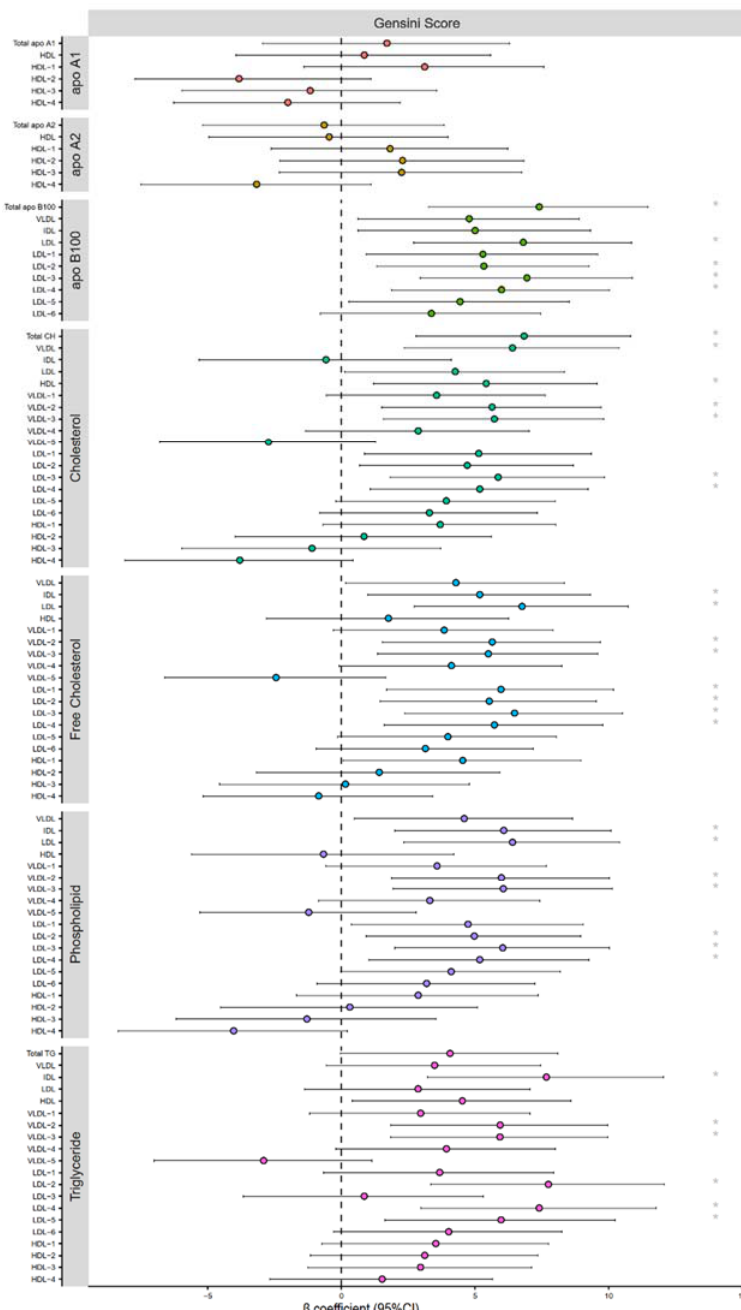
Figure 4. Multiple linear regression between lipoprotein composition concentration and Gensini score. Multiple linear regression β -coefficients (x-axis) expressed by standard deviation (SD) units indicate the change in Gensini score over lipoprotein composition concentrates. *: p -value < 0.05.